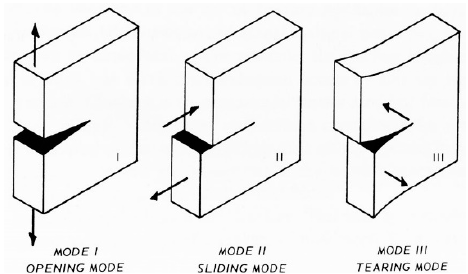
Figure 42. The three modes of failure in fracture mechanics.